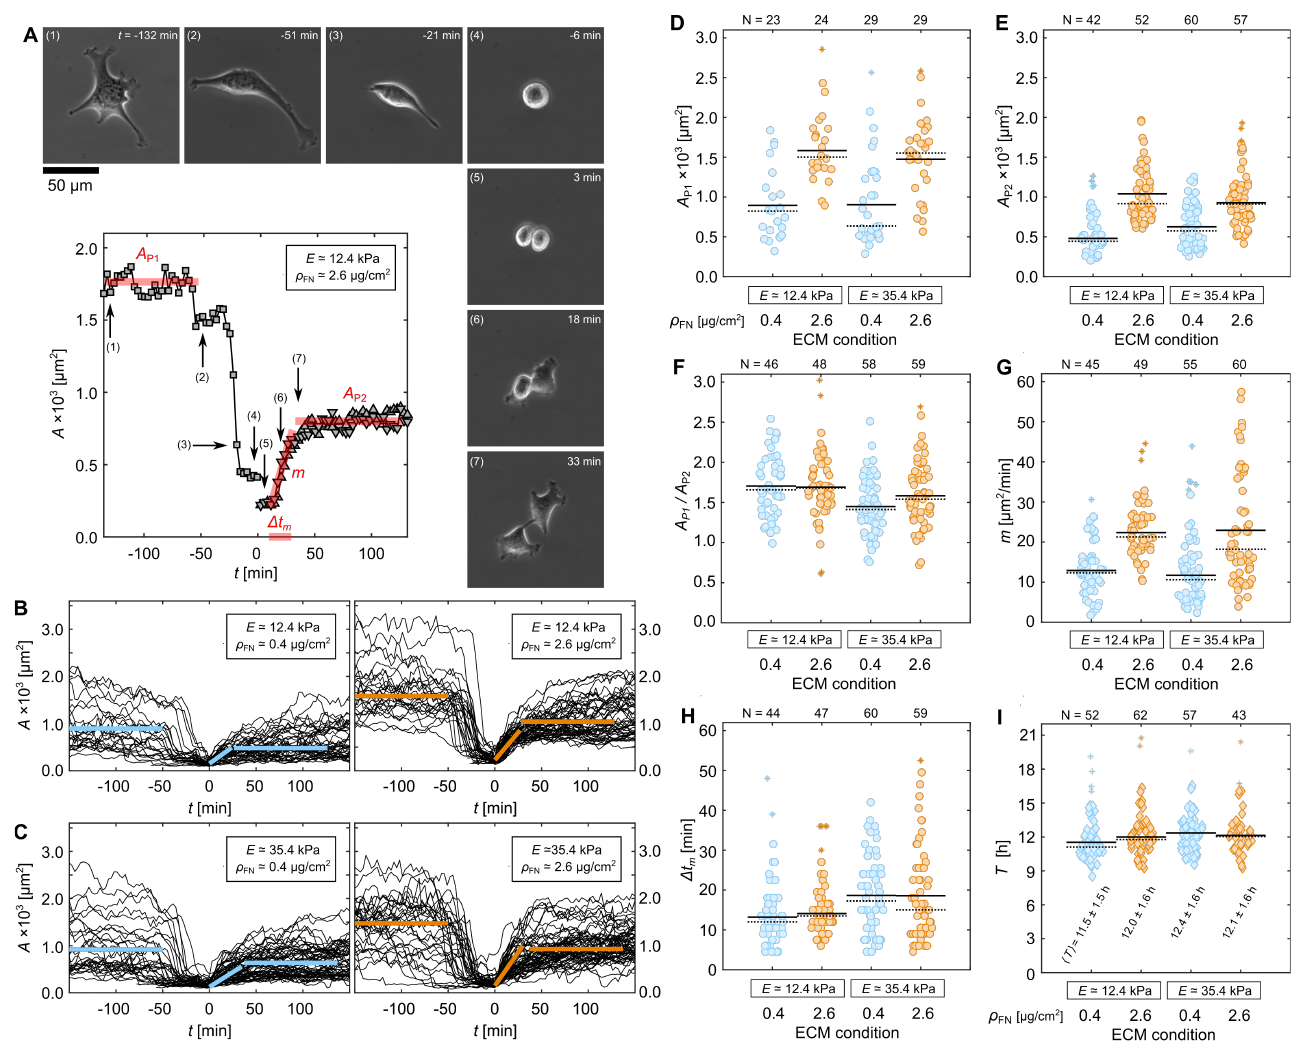
Figure 7. Proliferation dynamics depend on the ECM. ( A ) Example of a C2C12 muscle cell on a E (cid:39) 12.4 kPa hydrogel coated with ρ FN (cid:39) 2.6 µ g/cm 2 , and the corresponding projected cell area A as a function of time. ( B ) The time evolution of the A of cells cultured on E (cid:39) 12.4 kPa hydrogels coated with either 0.4 µ g/cm 2 ( left panel) or 2.6 µ g/cm 2 ( right panel). ( C ) The time evolution of the A of cells cultured on E (cid:39) 35.4 kPa hydrogels coated with either 0.4 µ g/cm 2 ( left panel) or 2.6 µ g/cm 2 ( right panel). ( D – H ) Statistical analysis of the cell trajectories ( B , C ). Shown are the following extracted parameters: area plateau of the mother cells A P1 , area plateau of the daughter cells A P2 , area ratio of mother to daughter cells A P2 / A P2 , initial spreading rate m after cell division, and duration of spreading ∆ t m as a function of E and ρ FN . The exemplary parameters are highlighted in solid red lines in ( A ). ( I ) Cell cycle duration T , i.e., duration between two successive cell divisions. Means and medians are illustrated by solid and dotted lines, respectively. Number of data points is written on top of the plots as N , excluding outliers that are highlighted by asterisks. Substrates functionalized with ρ FN (cid:39) 0.4 µ g/cm 2 and ρ FN (cid:39) 2.6 µ g/cm 2 are highlighted in blue and orange,